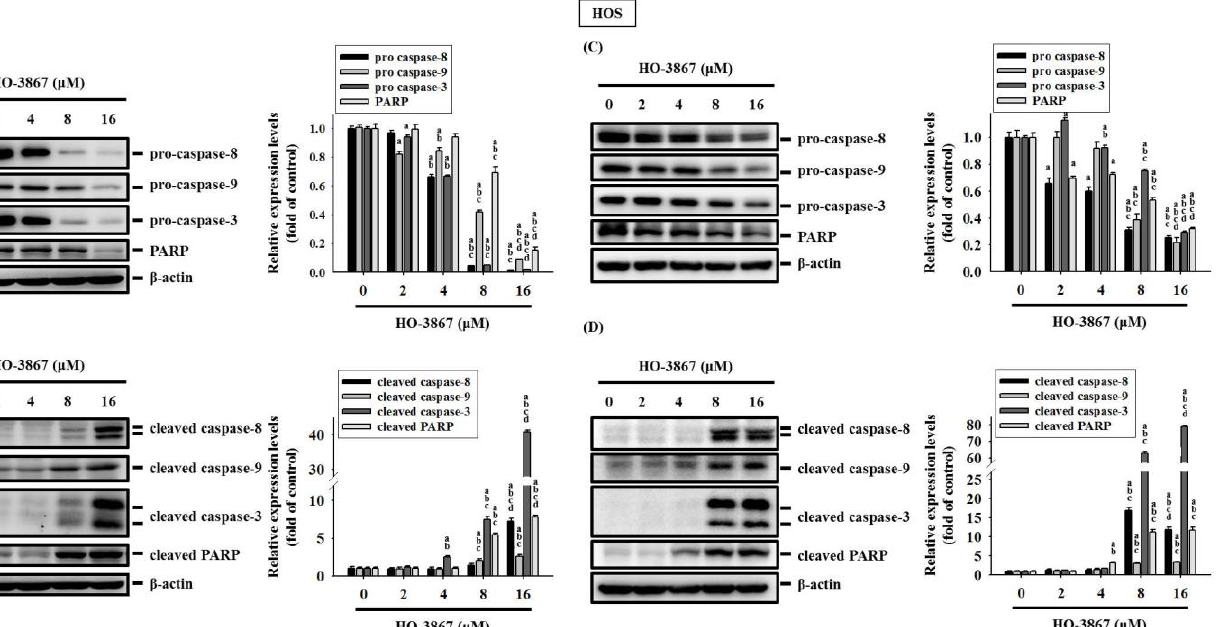
when compared to control. b Significantly different, p < 0.05, when compared to 2 µ M. c Significantly different, p < 0.05, when compared to 4 µ M. d Significantly different, p < 0.05, when compared to 8 µ